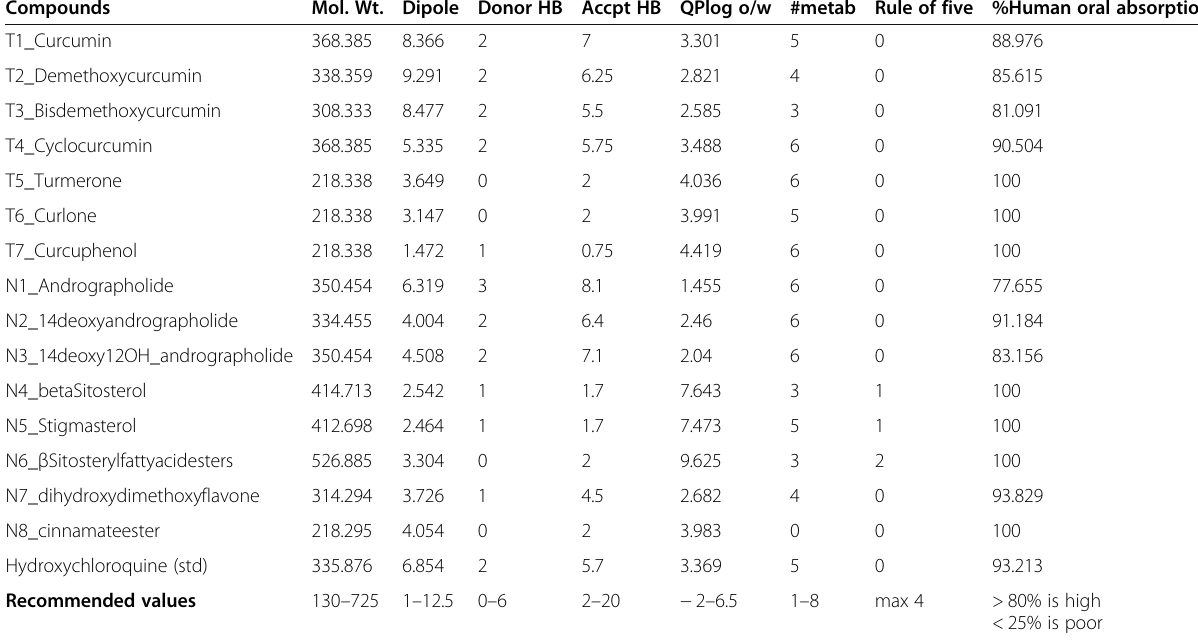
Table 2 In silico ADMET screening for phytochemical constituents of Curcuma longa (turmeric) and Andrographis paniculata